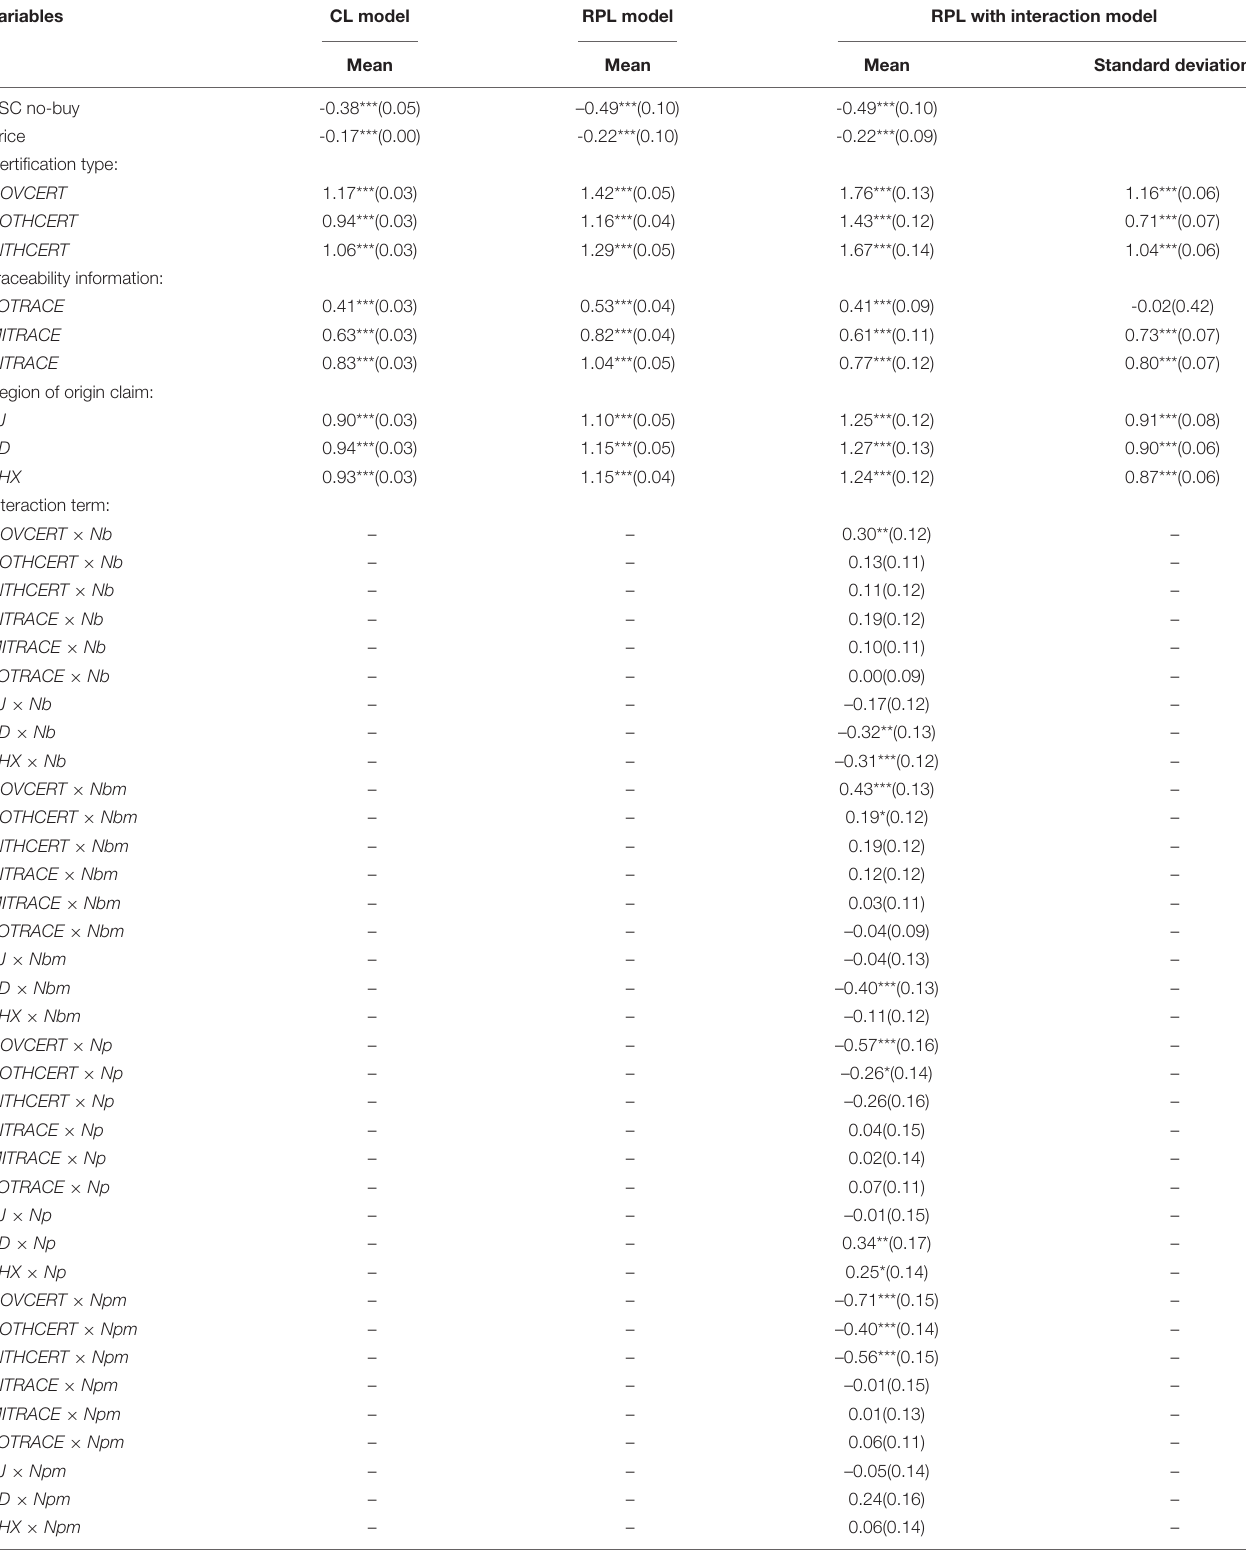
TABLE 2 | Estimates of parameters for CL, RPL, and RPL with interaction